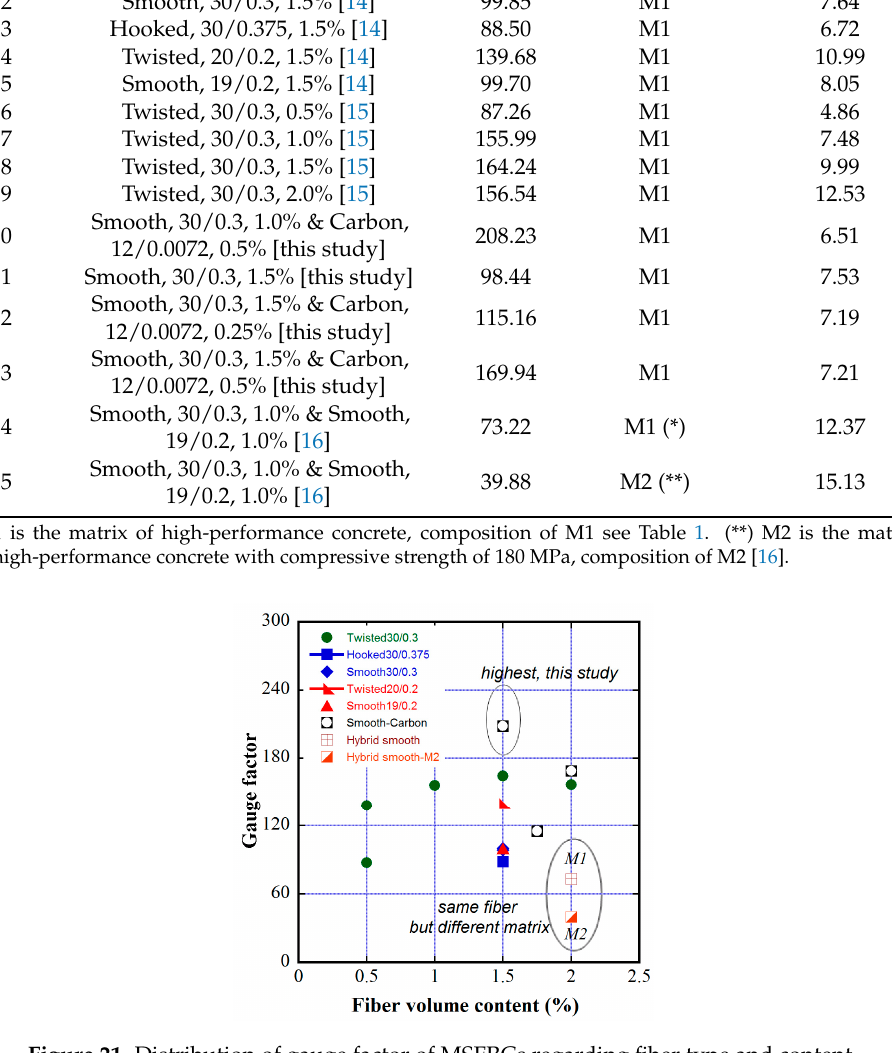
Figure 21. Distribution of gauge factor of MSFRCs regarding fiber type and content.